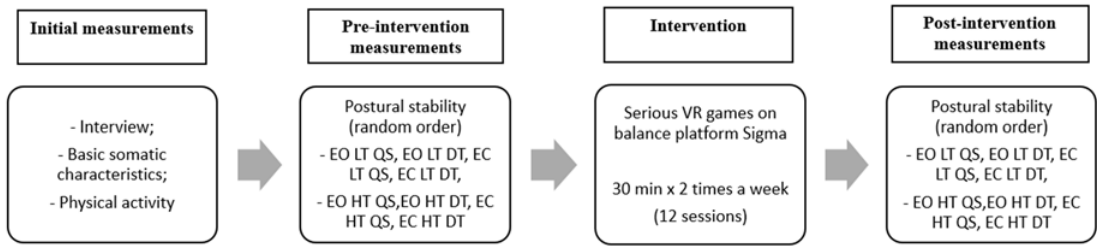
Figure 2. General overview of the experiment. EO—Eyes Open, EC—Eyes Open, LT—Low Threat, HT—High Threat, QS—Quiet Standing, DT—Dual Task.